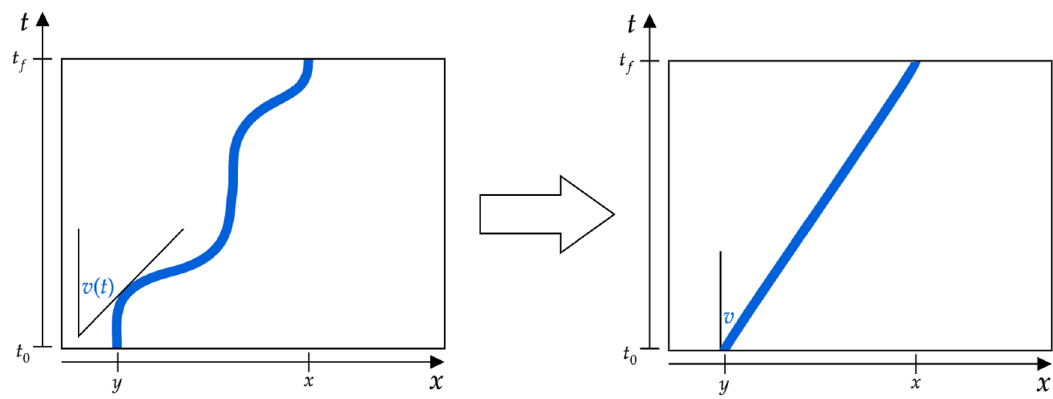
Figure 2 . Minimization over membranes brings the curve on the left where a membrane stretches from y to x with a velocity v ( t ) assigned as the angle from the vertical at each point in time to a straight